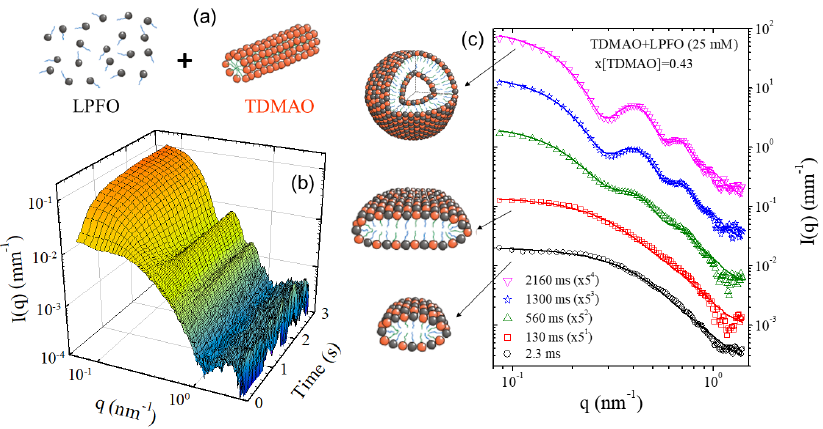
Figure 7. Self-assembly of unilamellar vesicles upon rapid mixing of 25 mM solutions of anionic lithium perfluorooctanoate (LPFO) surfactant and zwitterionic tetradecyldimethylamine oxide (TDMAO) micelles. ( a ) Schematic representation of the initial morphologies of LPFO (below the critical micellar concentration) and TDMAO cylindrical micelles. ( b ) Time evolution of the SAXS intensity from a few milliseconds up to several seconds. ( c ) Modelling of selected SAXS profiles depicting the morphological change from the initially formed disk-like micelles to unilamellar vesicles when the size of the disks become larger. Adapted from J. Gummel et al. [62] c the Royal Society of Chemistry 2011. (cid:13)